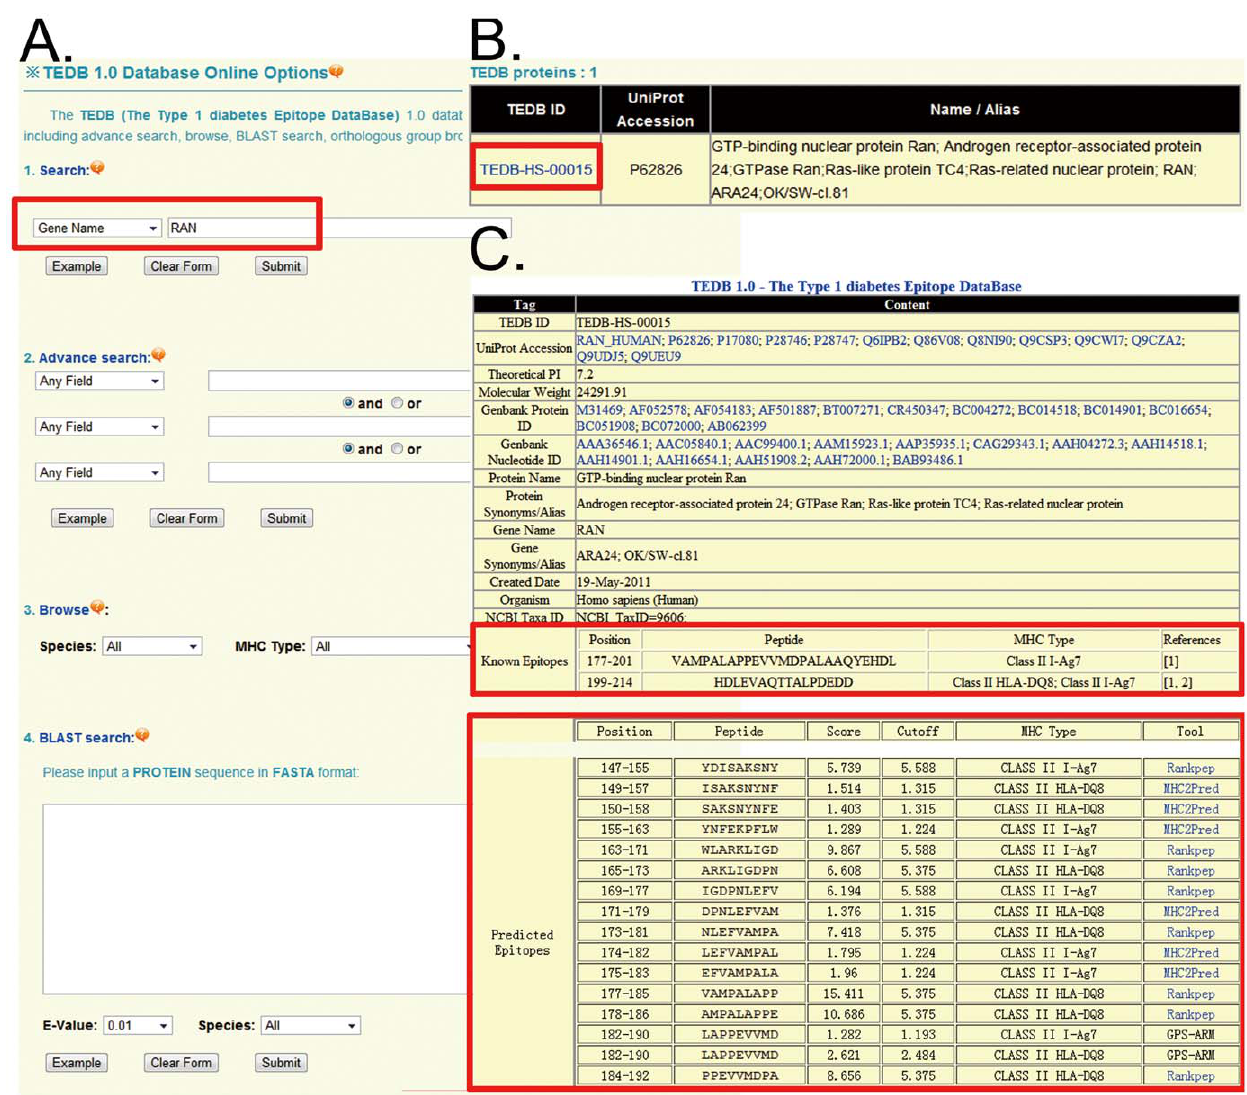
Figure 4. The search options for the TEDB 1.0 database. (A) Users are able to simply input ‘RAN’ and select ‘‘Gene Name’’ for querying. (B) The results are shown in a tabular format. Users can then click on the TEDB ID (TEDB-HS-00015) to visualize the detailed information. (C) The detailed information on human RAN. The experimentally identified and predicted epitopes are presented. doi:10.1371/journal.pone.0033884.g004 PLoS ONE |